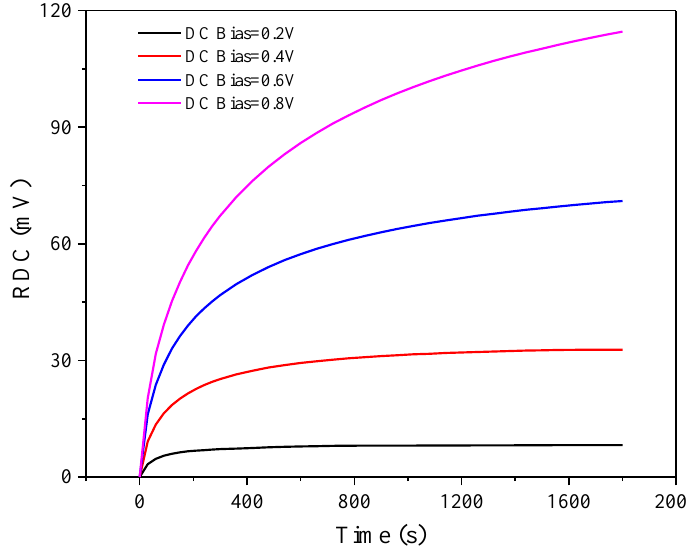
Figure 6. Residual DC voltage with time under different bias voltages in pure LC materials.